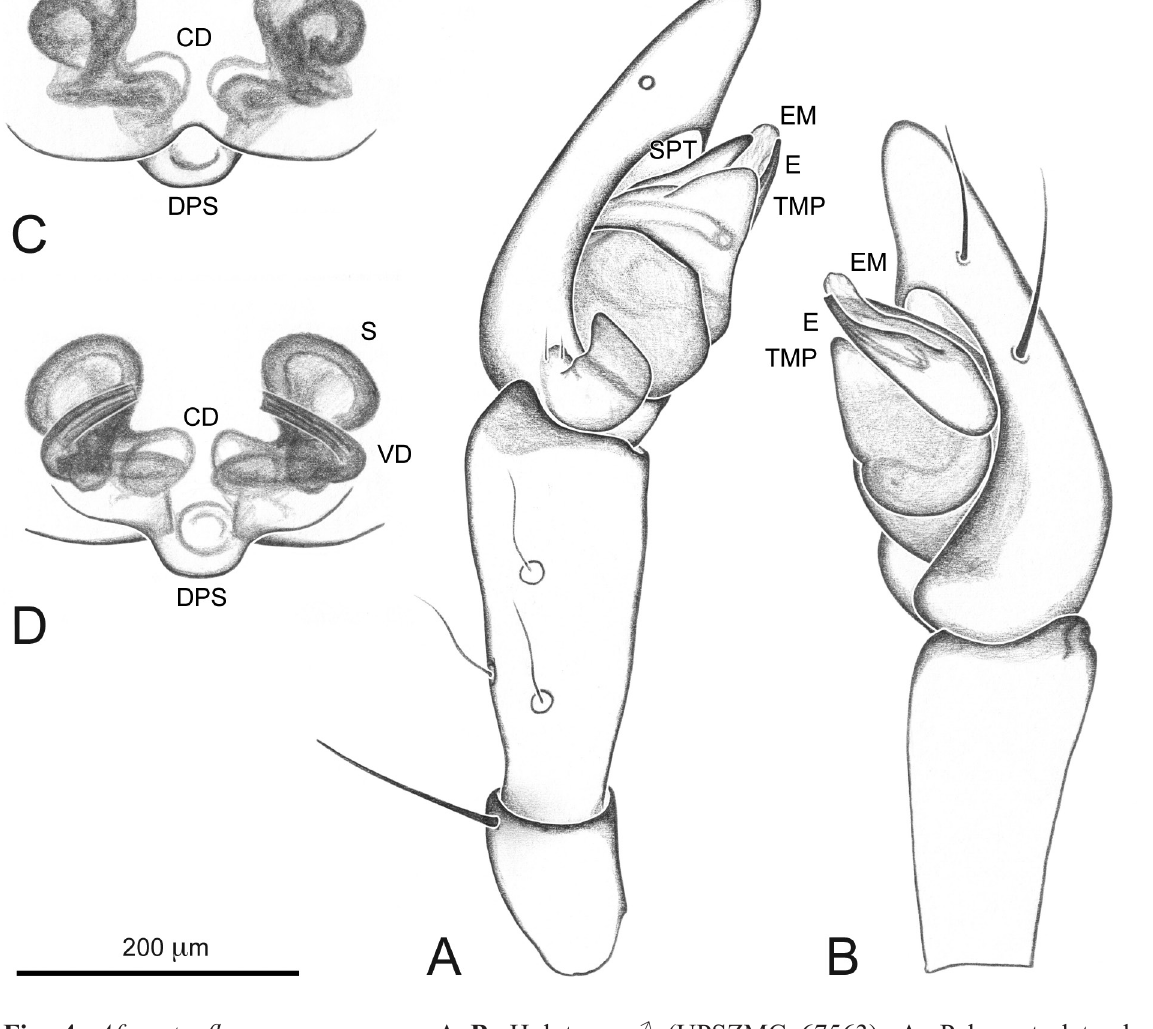
Fig. 4. Afroneta flavescens sp. nov. A–B . Holotype, ♂ (UPSZMC 67563). A . Palp, retrolateral. B . Prolateral. C–D . Allotype, ♀ (UPSZMC 67564). C . Epigyne, ventral. D . Vulva,